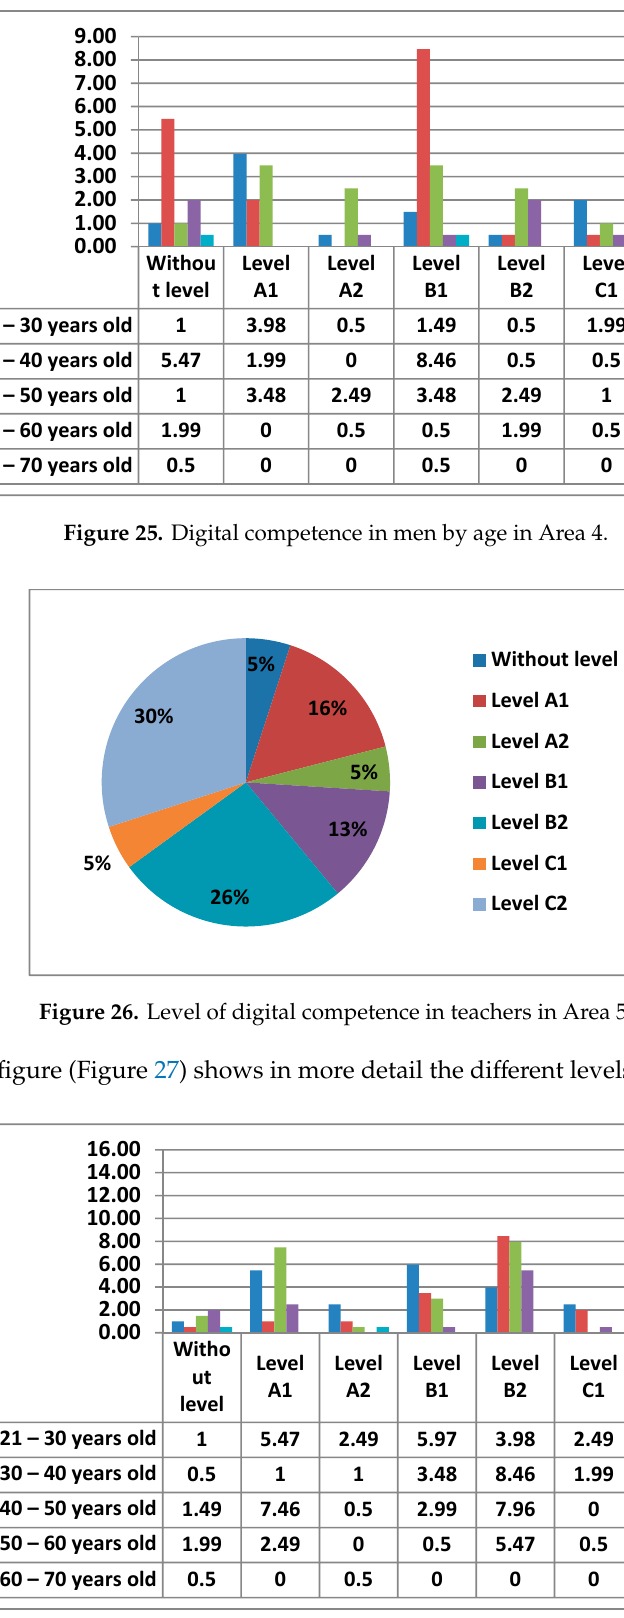
Figure 24. Digital competence in women by age in Area 4.